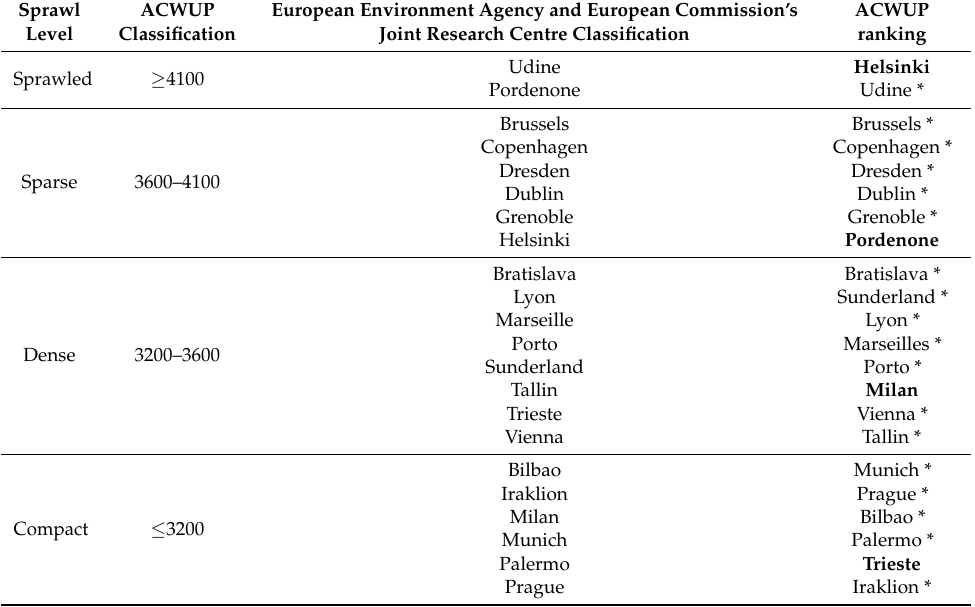
Table 1. Correspondence between the European Environment Agency and European Commission’s Joint Research Centre’s sprawl classification and the ACWUP classification, aggregated using natural breaks (cities are listed in the order by which they were ranked in the European Environment Agency and European Commission Joint Research Centre’s classification: e.g., Udine is more sprawled than Pordenone). Cities with * in the ACWUP ranking column correspond to matches with the EEA classification while cities in bold correspond to miss-matches.